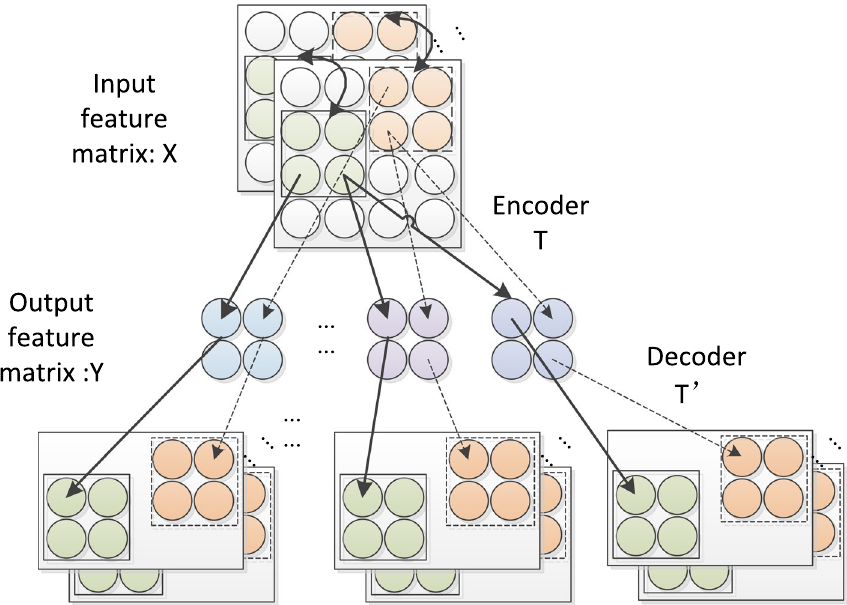
Fig. 1 Schematic diagram of a convolutional autoencoder